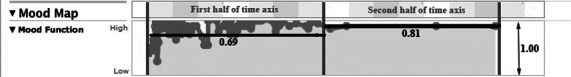
Schematic diagram of how to calculate the rate of change of a recovery curve.This diagram shows a time series of a patient’s mood function changes.